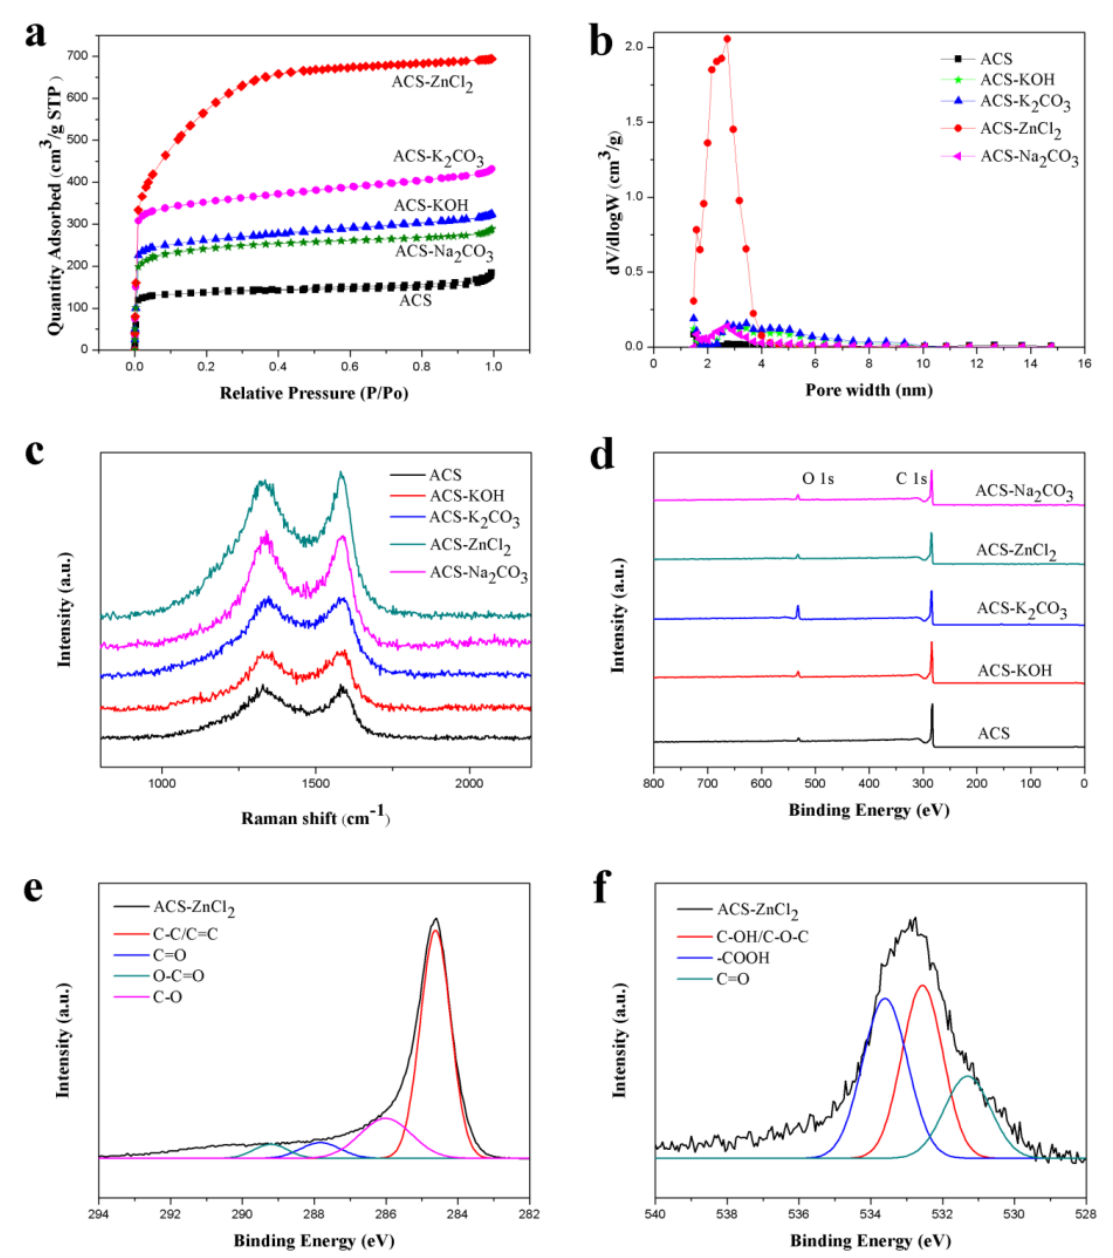
Figure 3. ( a ) N 2 adsorption–desorption isotherms, ( b ) pore size distributions, ( c ) Raman spectra, ( d ) XPS spectra of activated carbon spheres, and XPS spectra of ( e ) C 1s and ( f ) O 1s of ACS-ZnCl 2 .